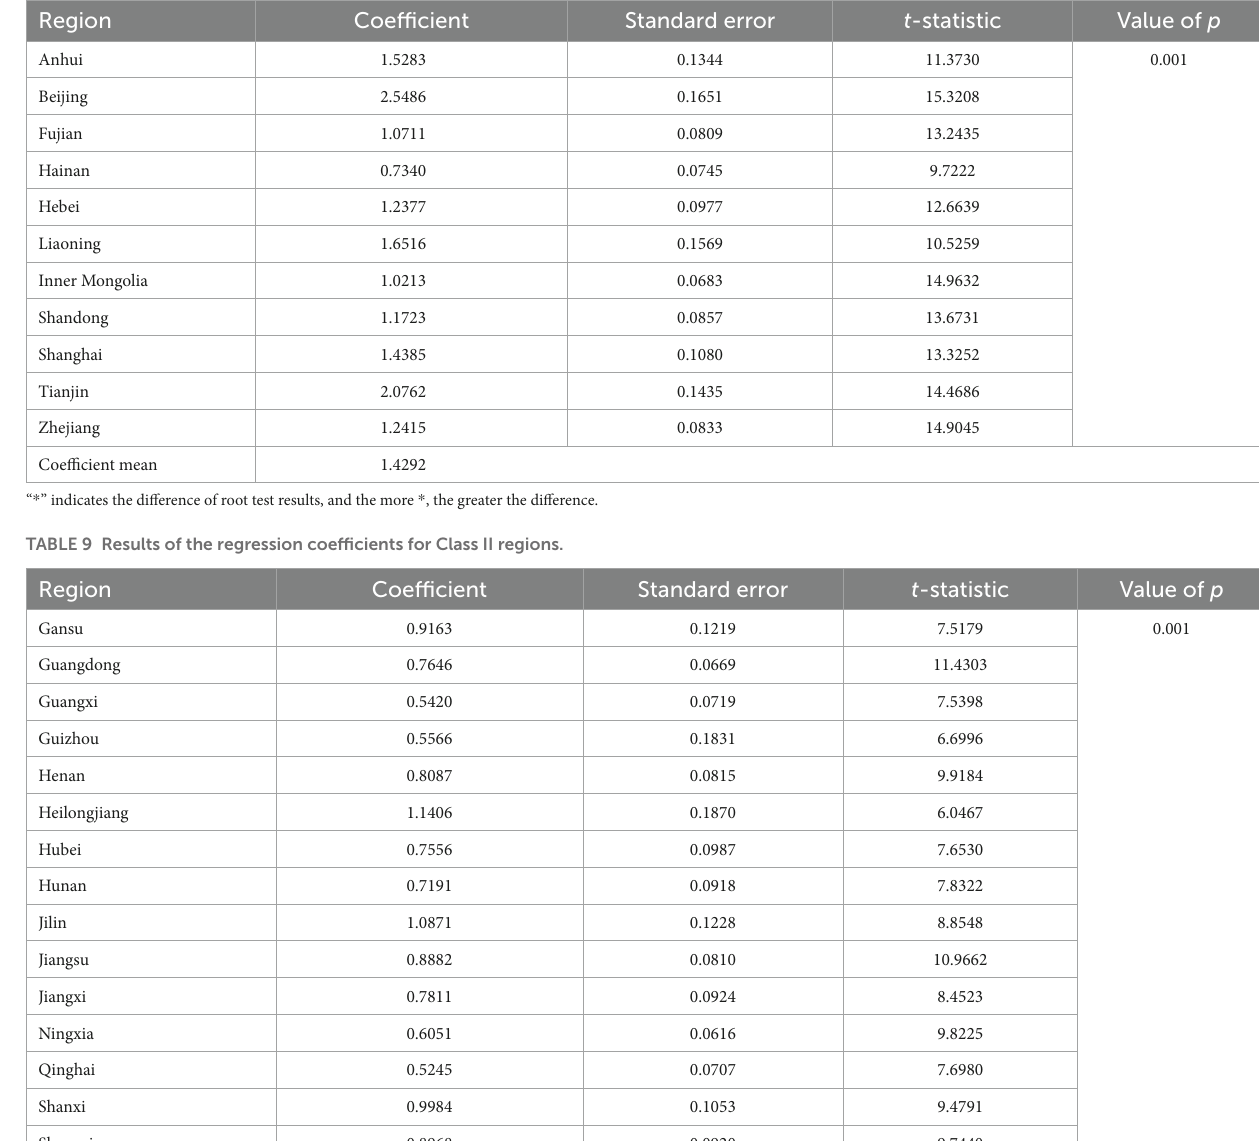
TABLE 8 Results of the regression coefficients for Class I